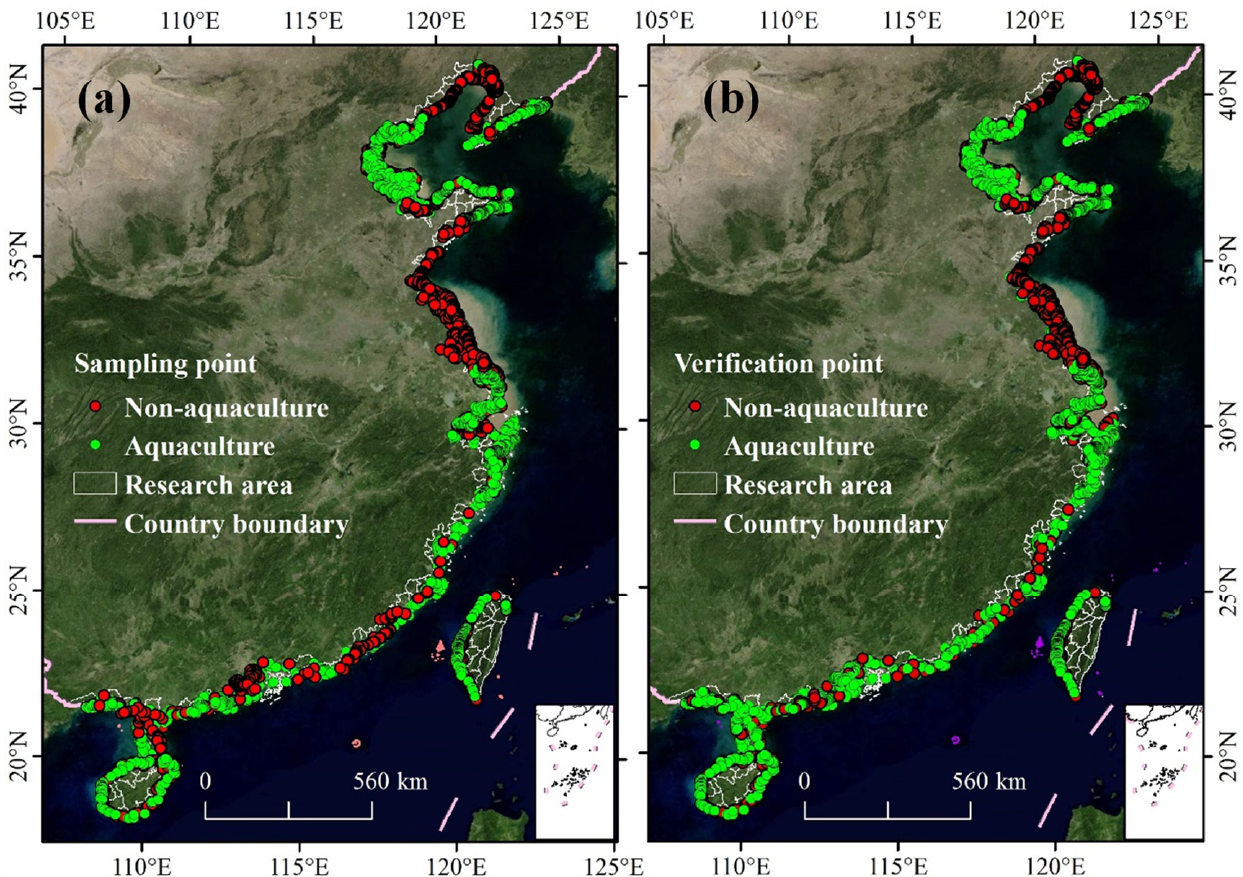
Figure 5. Spatial distribution of ( a ) sampling points and ( b ) verification points.